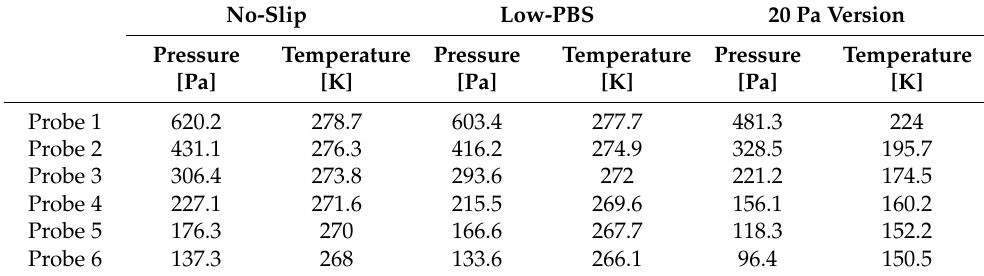
Table 3. Values of variables at probing